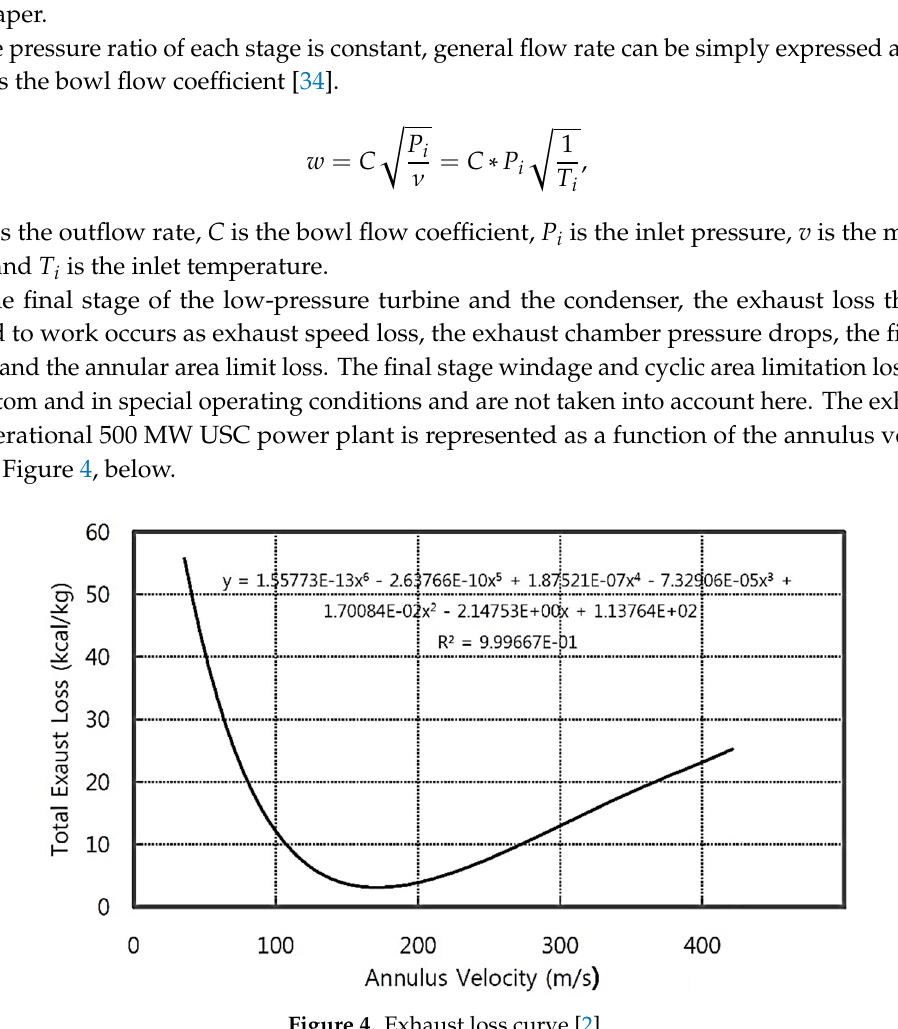
Figure 4. Exhaust loss curve [2] .